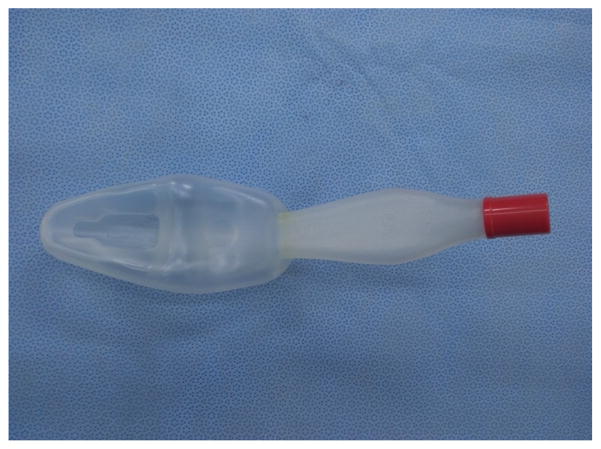
Slipa LMAFigure.